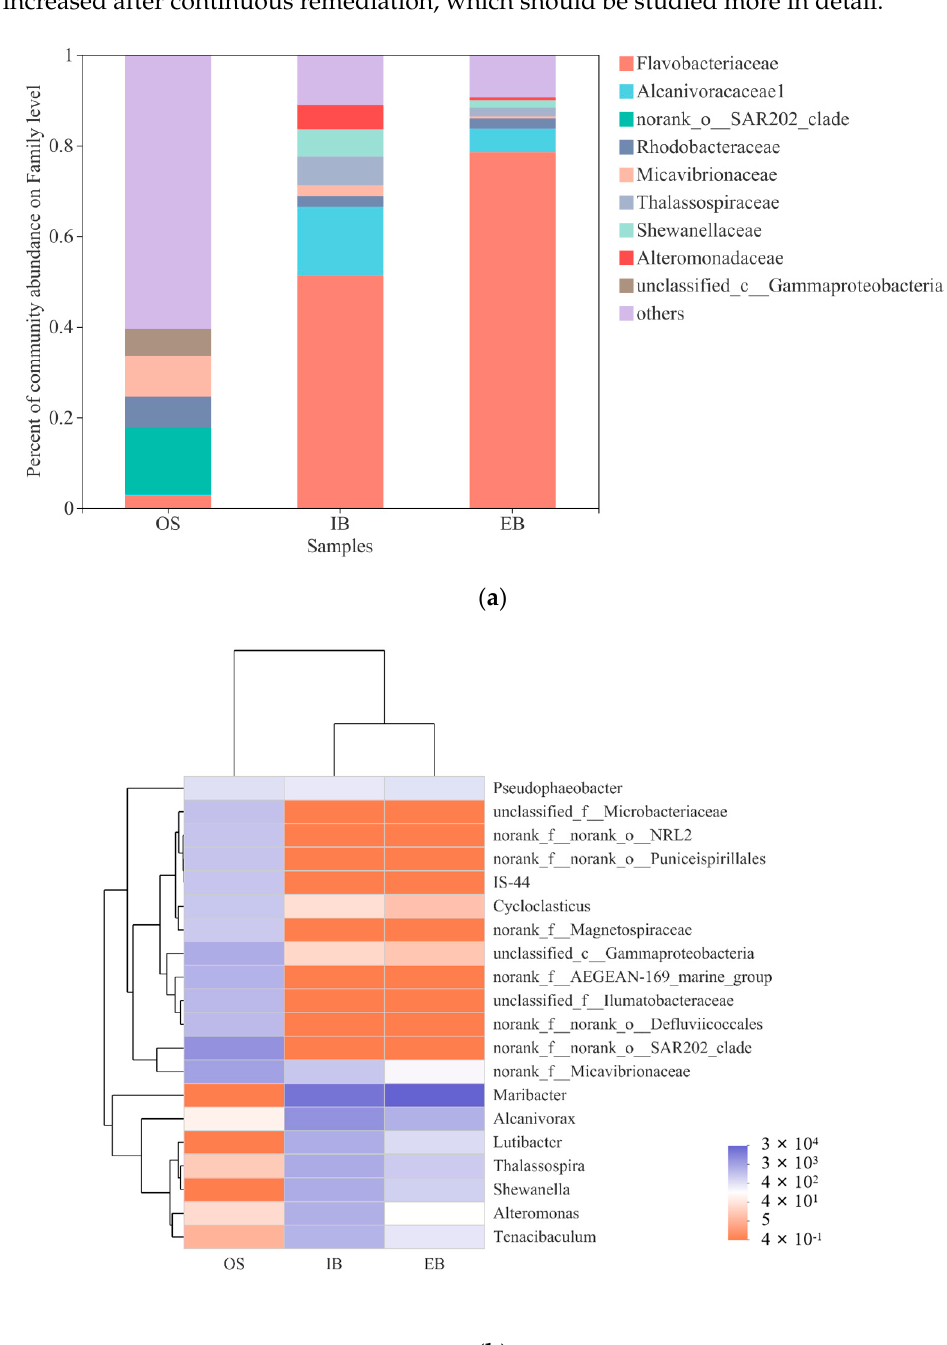
Figure 5. ( a ) Community structures at the family level in the original seawater (OS) and in the immobilized petroleum–degrading bacteria beads in different areas of the bioreactor. ( b ) Community composition heatmap at the genus level for the original seawater (OS) and for the immobilized petroleum–degrading bacteria beads in different area of the bioreactor (water inlet site (IB); water outlet site (EB)).